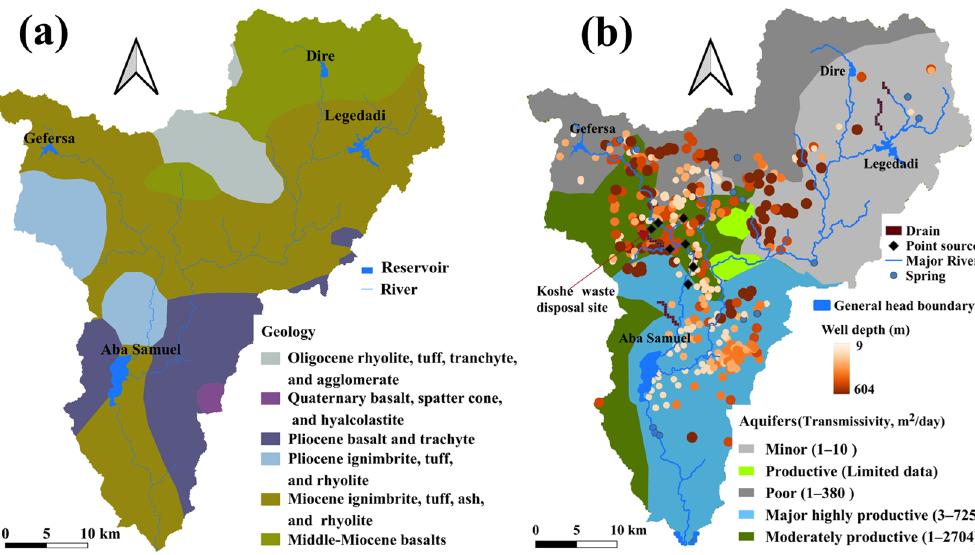
Figure 3. Geology and hydrogeology of Akaki River Basin, obtained from the Ministry of Water Resources, Irrigation, and Electricity (EMWRIE), the principal boundary conditions considered in the groundwater flow modeling, and location of contaminant point sources, processed using QGIS3.10.4 (https:// www. qgis. org/ en/